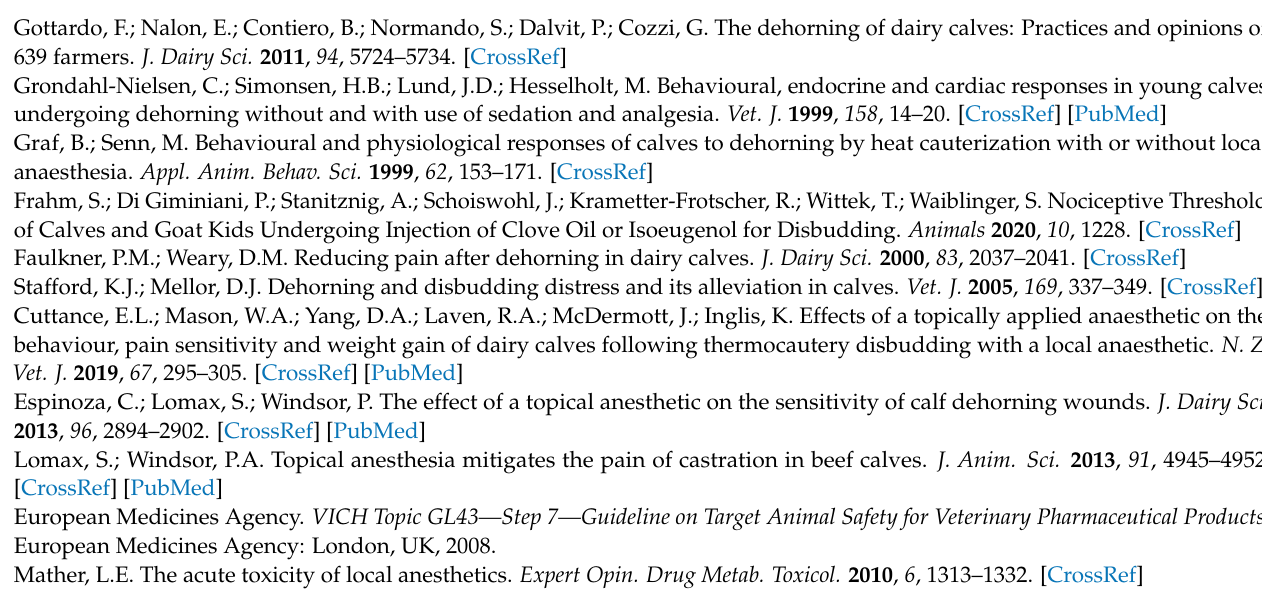
1, Table S2: Group mean key haematological parameters over time for animals in Experiment 1, Table S3: Group mean key biochemical parameters over time for animals in Experiment